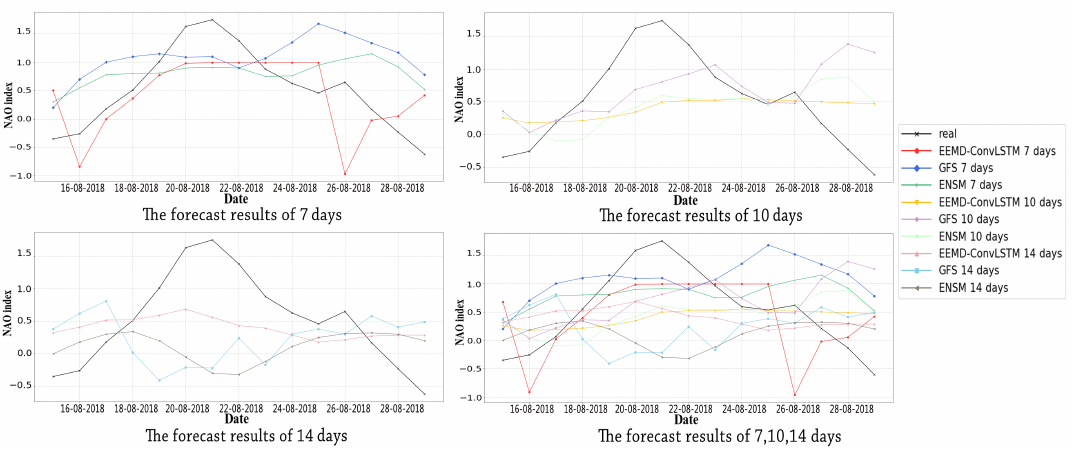
Figure 9. The forecast results of different models. GFS, Global Forecast System (GFS). ENSM, The averaging of 11 Medium Range Forecast (MRF) model ensemble members (ENSM).